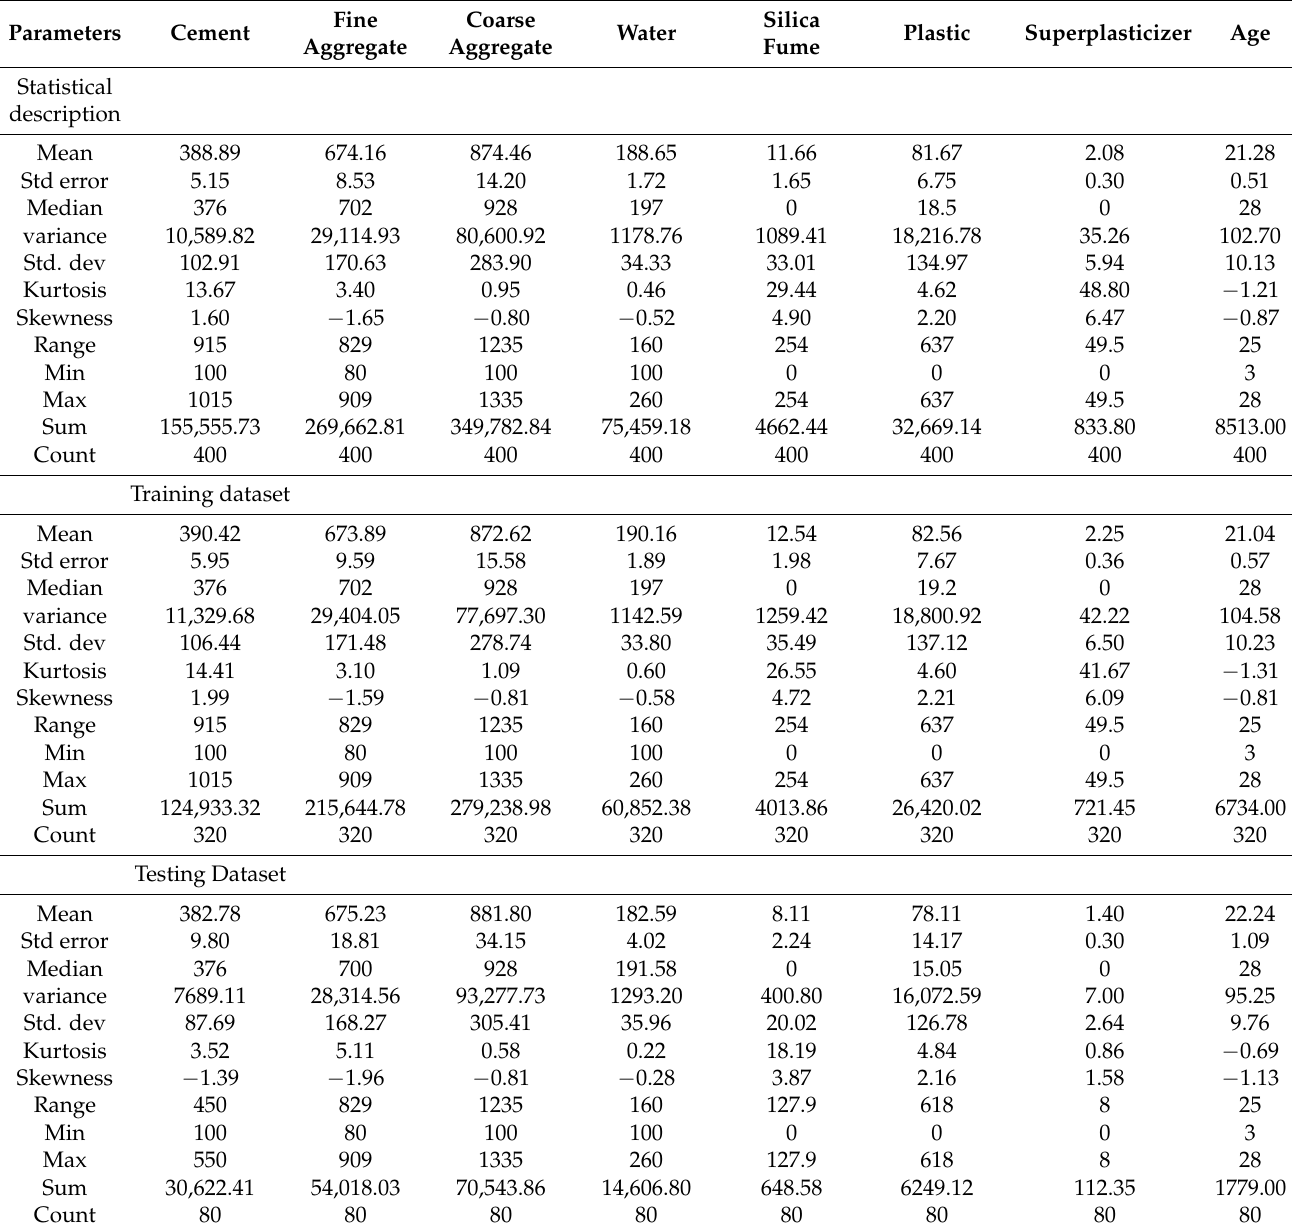
Table 6. Data statistical description for tensile strength model’s parameters (kg/m 3